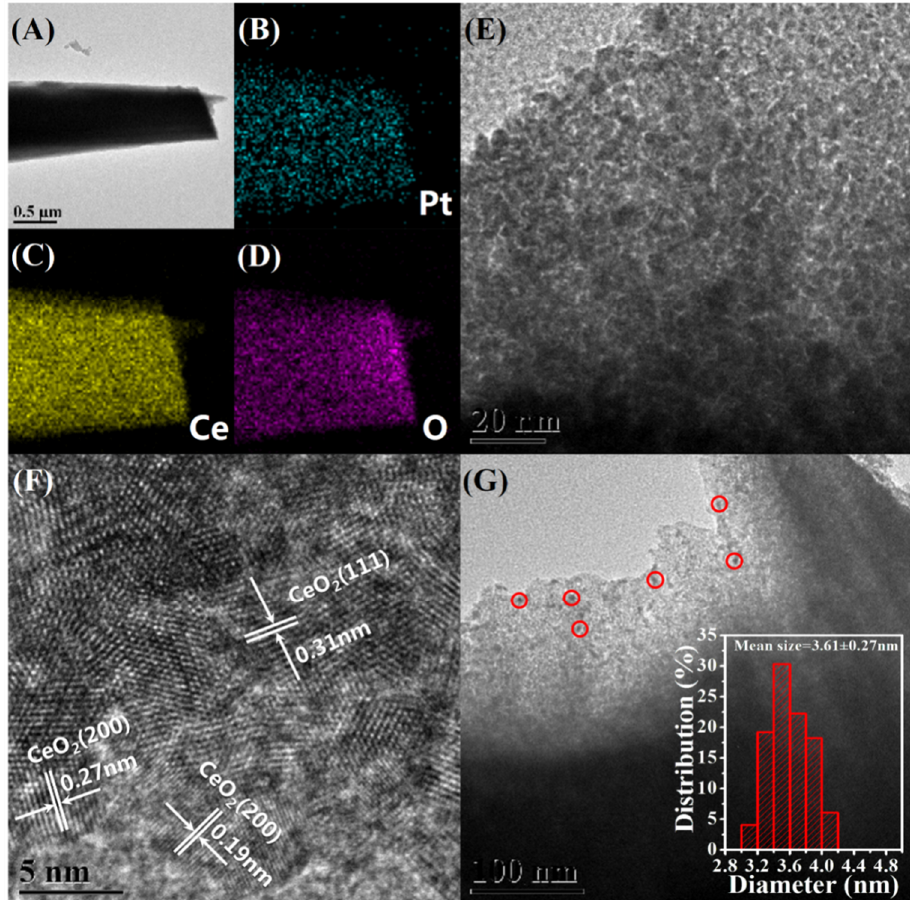
Figure 3. Morphology and structure of Pt(EG)@CeO 2 (N 2 -Air). ( A , E ) TEM images, ( F ) HRTEM images, ( G ) the distribution of Pt NPs and the inset is histogram of the size distribution of Pt NPs, ( B – D ) EDX elemental mapping images of Pt, Ce, and O, respectively.